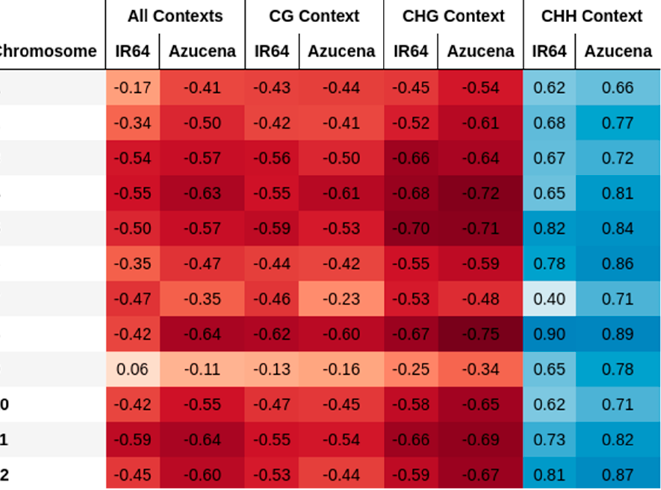
Figure 2. Correlations between recombination rates and the count of methylated cytosines for rice varieties IR64 and Azucena. Blue and red colors correspond to positive and negative correlations, respectively. The higher the correlation value, the higher the color intensity.